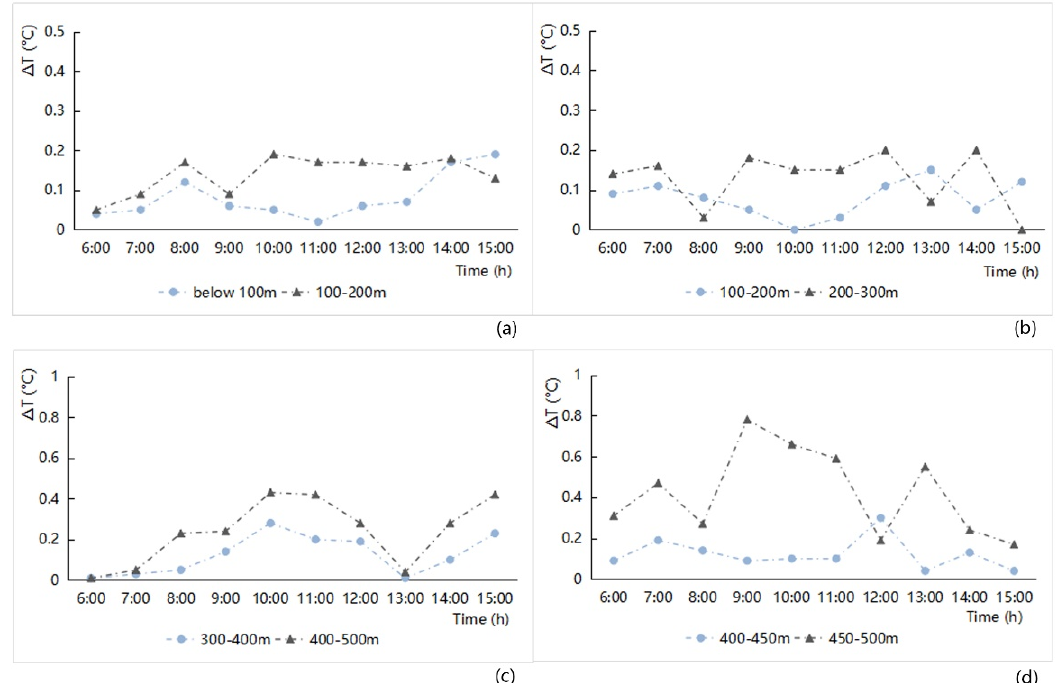
Figure 6. Hourly ΔT variation analysis related to different grade junction spacings of the street network from 6:00 to 15:00 in the four study areas (( a ) Old downtown; ( b ) Gubei international community; ( c ) Anting New Town; ( d ) New Jiangwan Town).